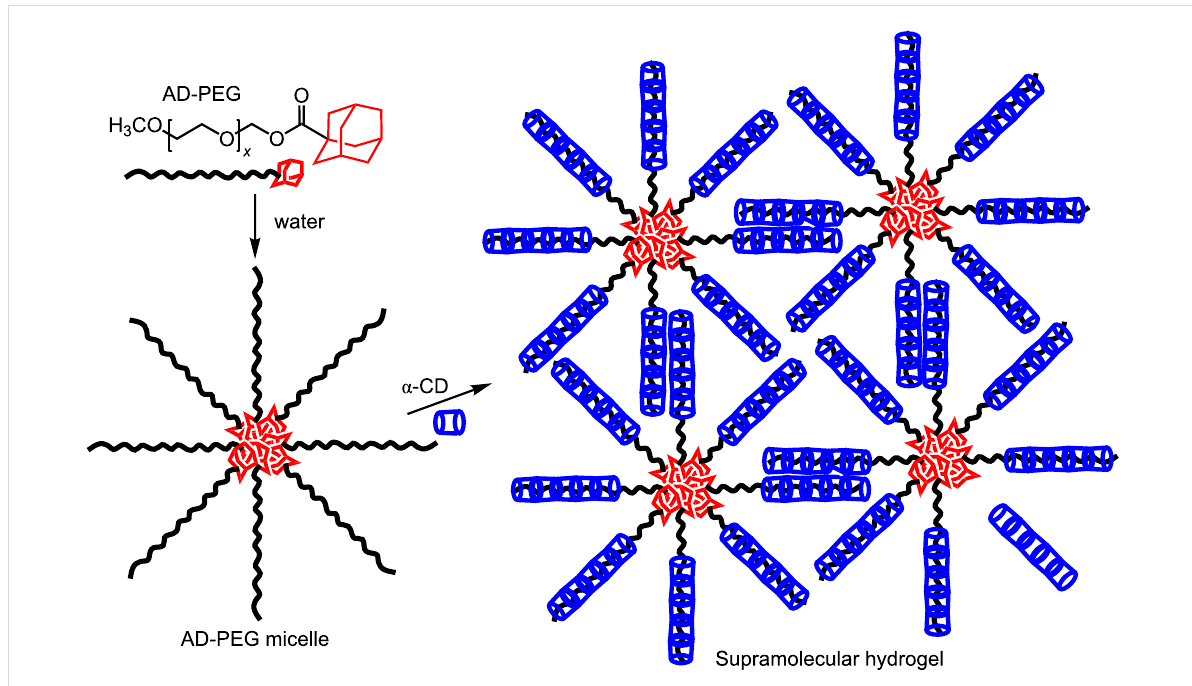
Figure 11: The formation of a AD-PEG micelle followed by the formation of a AD-PEG/ α -CD supramolecular hydrogel in aqueous solution [88].